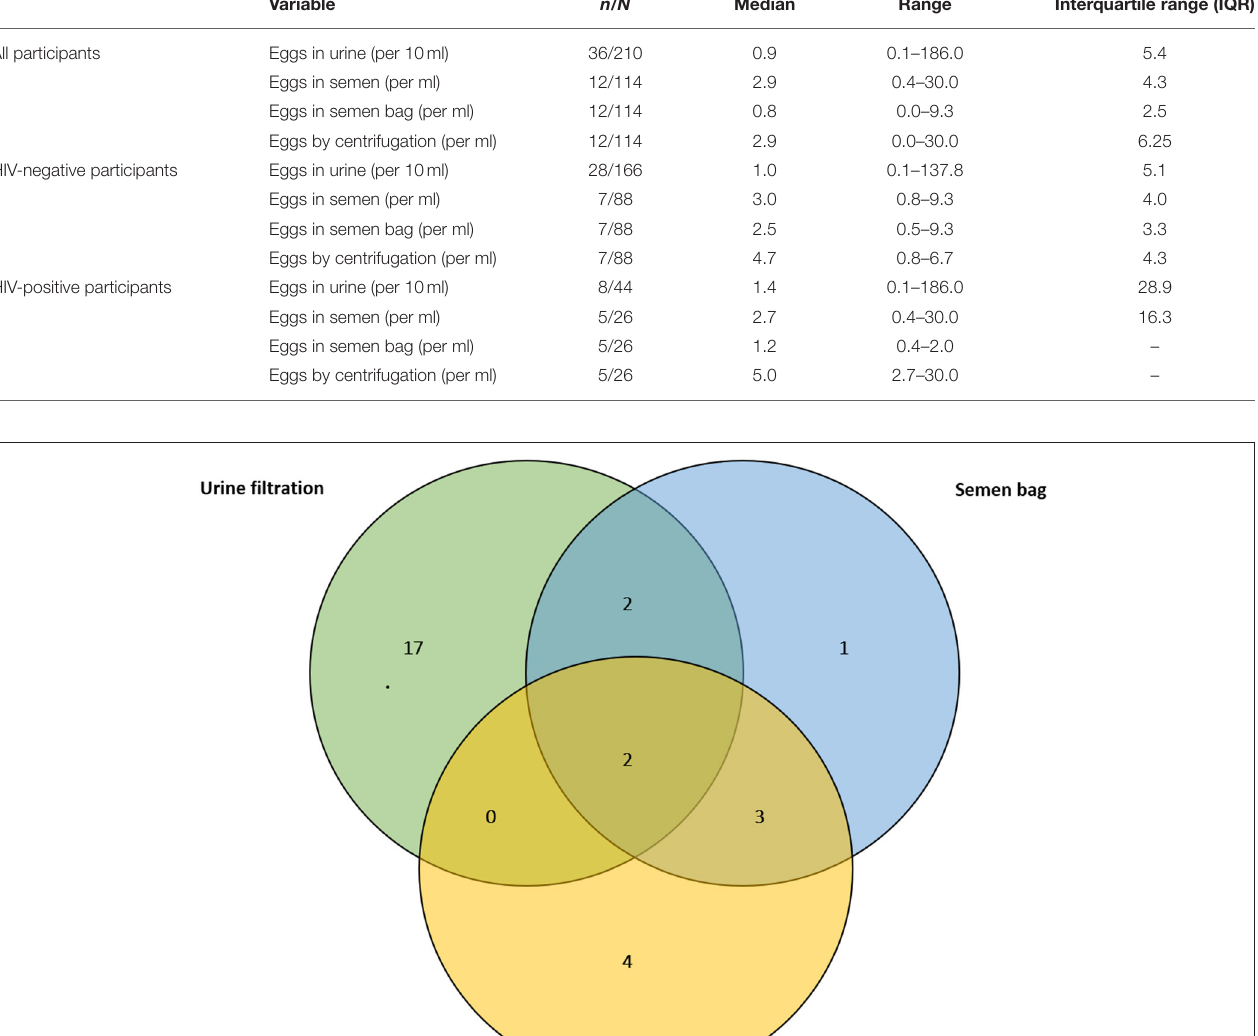
and sexually transmitted infections (STI, 6.4%) ( Table 7